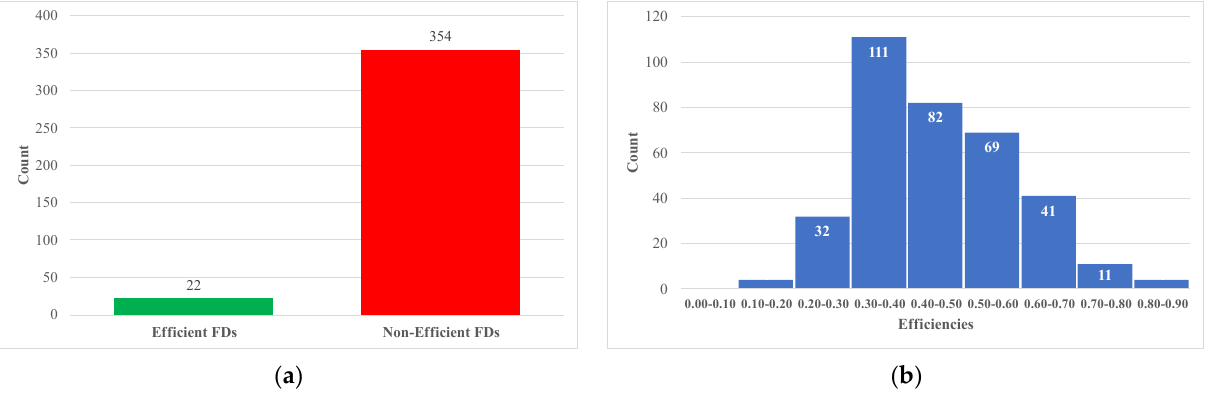
Figure 4. ( a ) Efficient/nonefficient PT FDs in 2020, ( b ) Efficiency distribution of the nonefficient FDs.